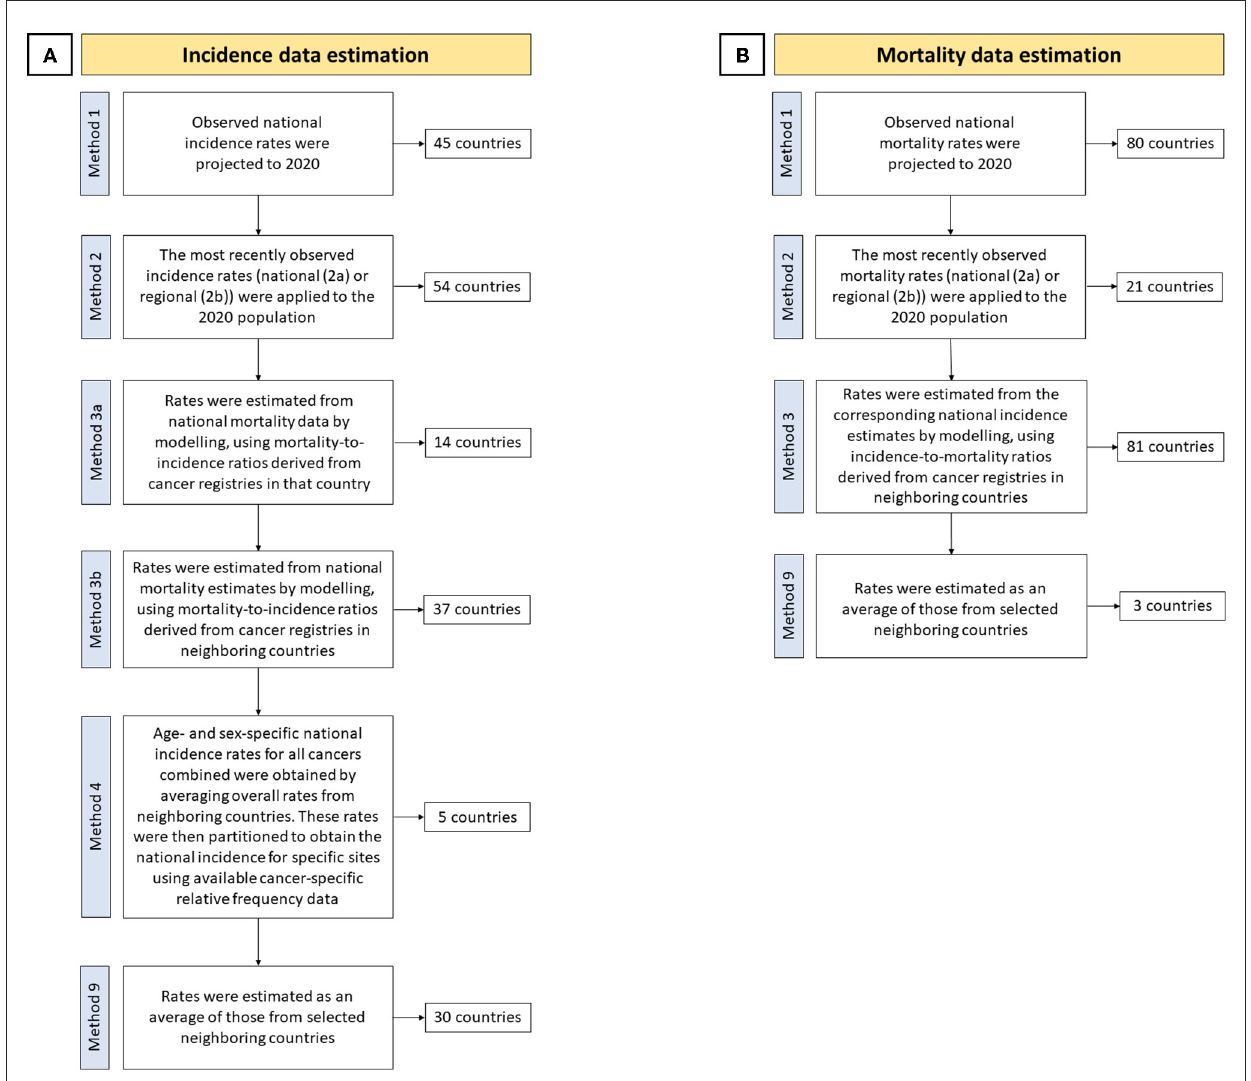
FIGURE1 Cancer (A) incidence and (B) mortality estimation steps and methods in the GLOBOCAN 2020 study (34).